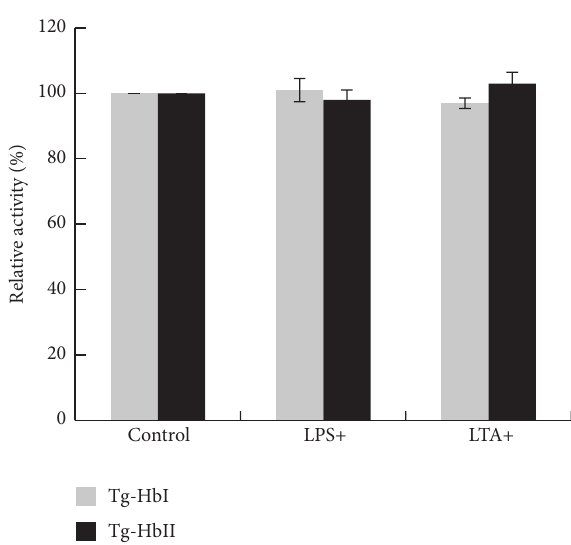
Figure 5: The effect of LPS and LTA on Tg-Hb peroxidase activity.